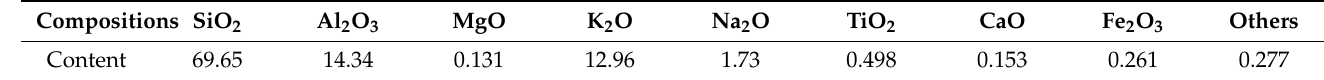
Table 1. Chemical compositions of tuff in wt.%.